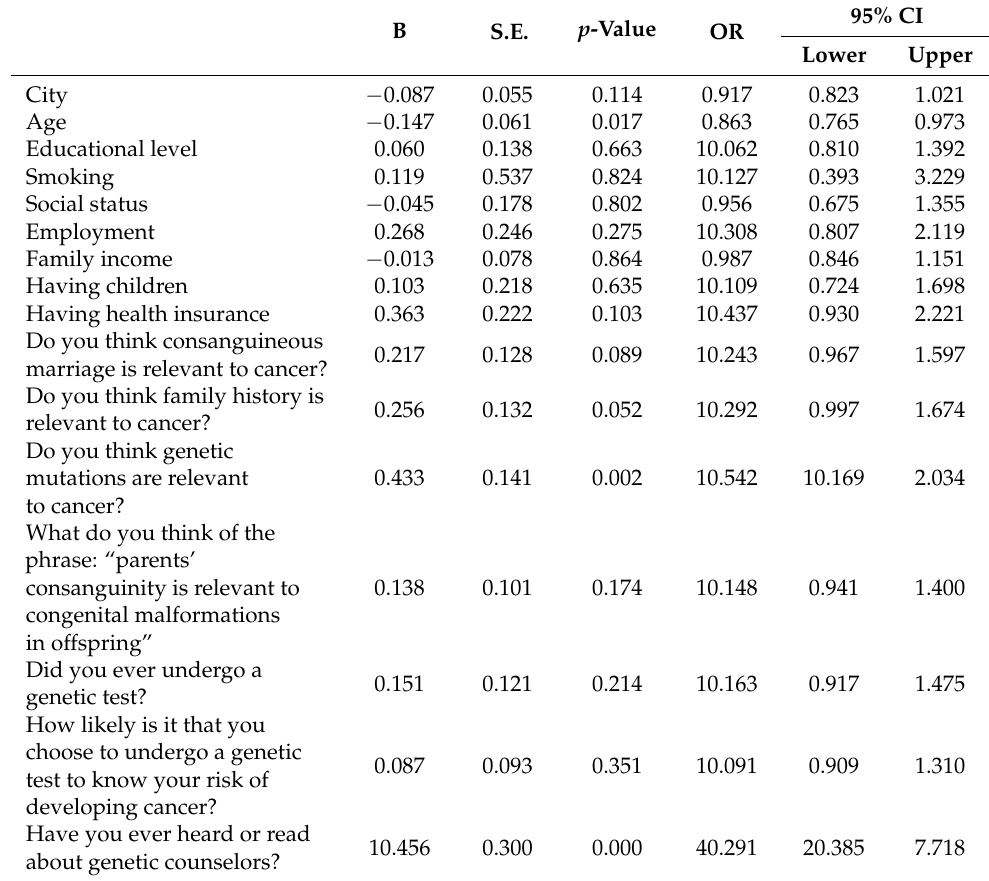
Table 3. Univariate analysis for the assessment of the factors influencing awareness of family and inherited cancer.